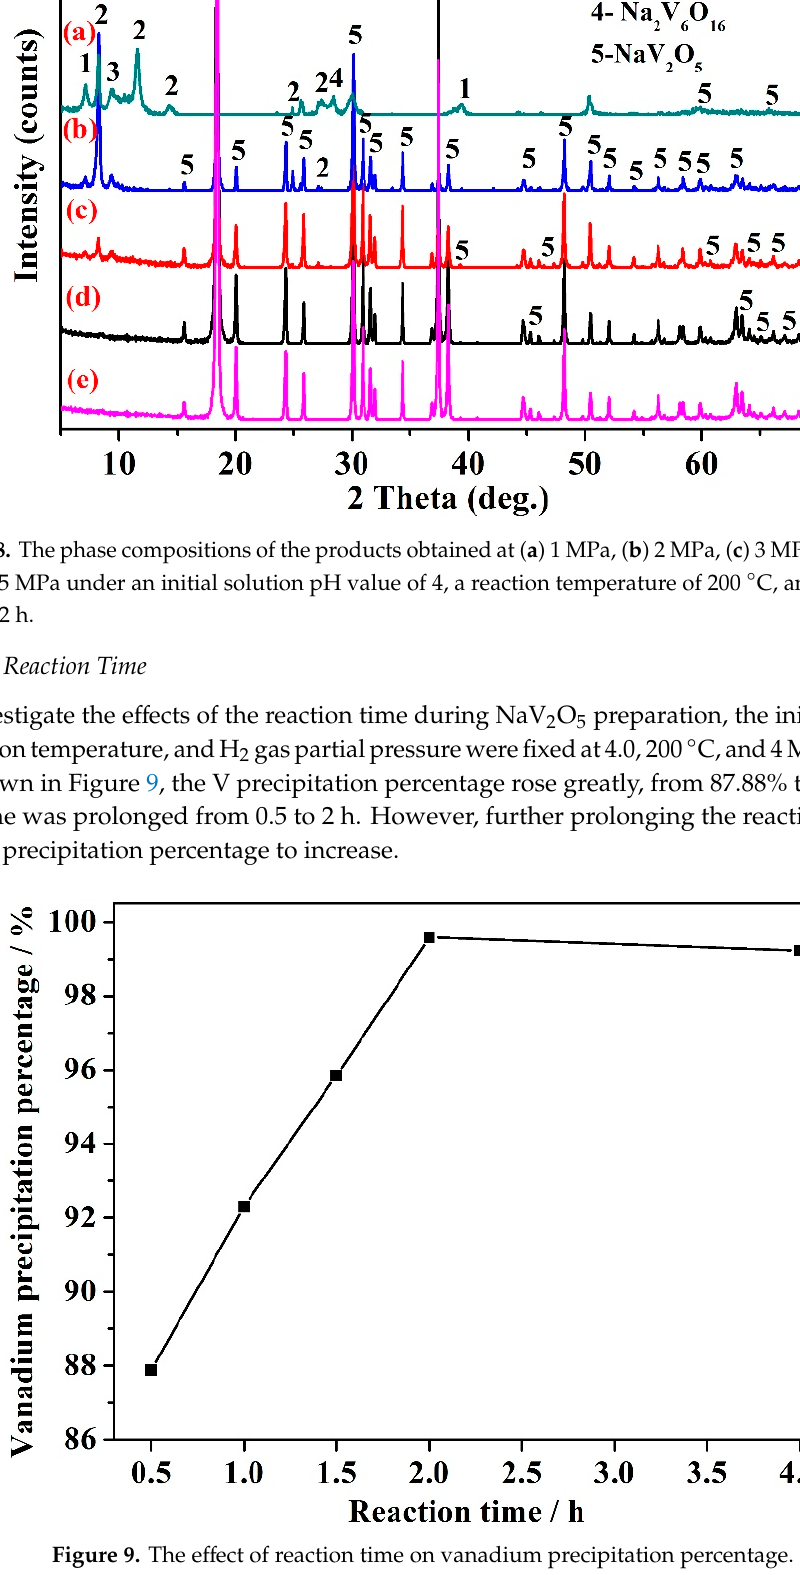
Figure 7. The effect of H 2 gas partial pressure on vanadium precipitation percentage.